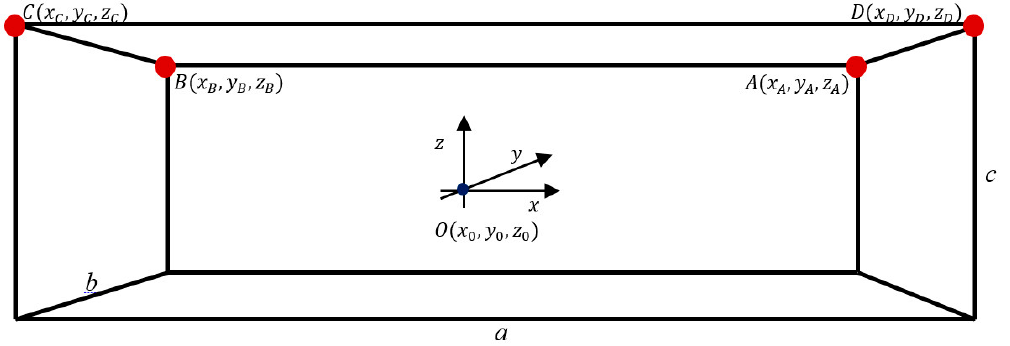
Figure 3. Model of 3D indoor environment.